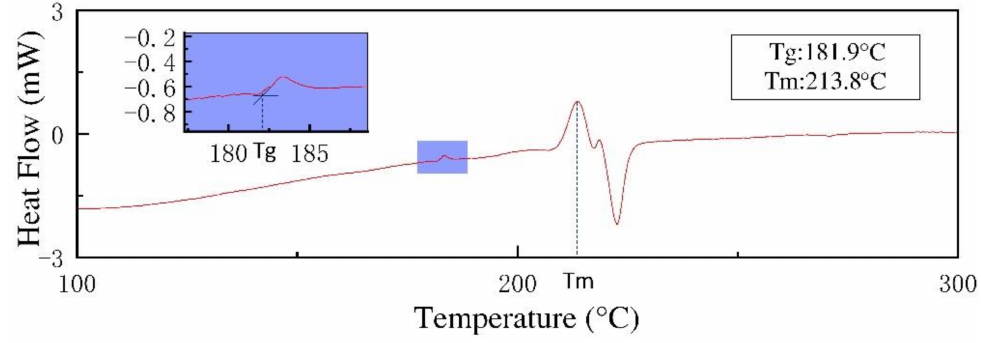
Figure 3. DSC testing of the